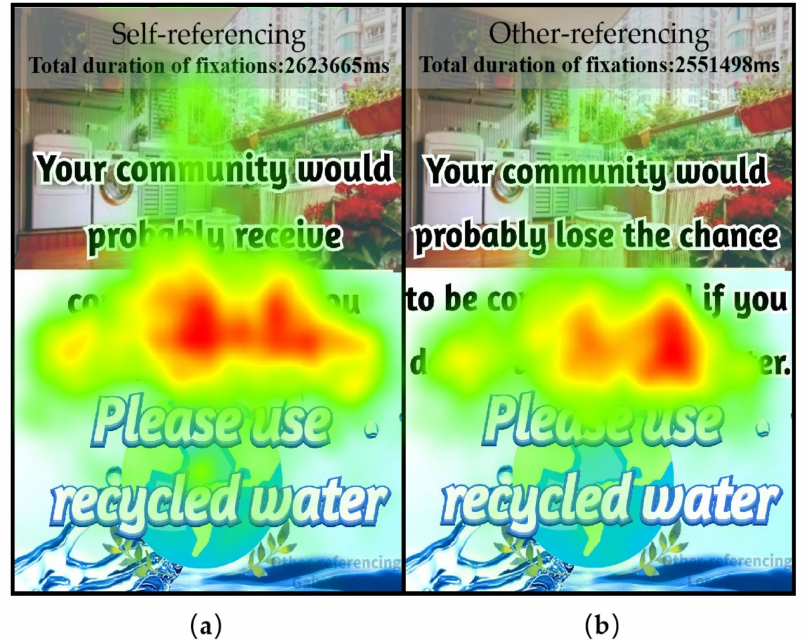
Figure 5. Eye-tracking heat map of posters with different points of reference. ( a ) Eye-tracking heat map of self-referencing; ( b ) Eye-tracking heat map of